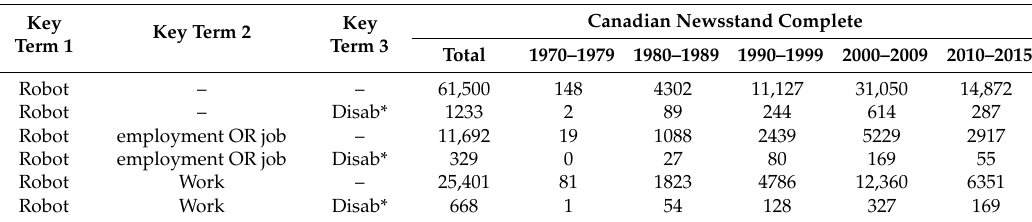
Coverage of the topic of employment of disabled people and robots within Canadian